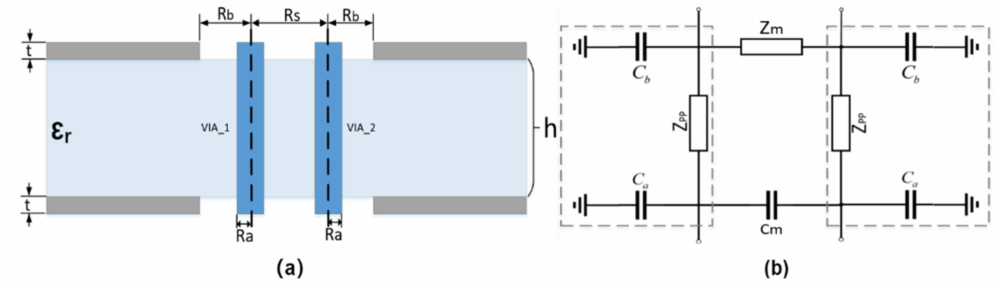
Figure 6. ( a ) Schematic diagram of differential vias section; ( b ) differential vias π -type equivalent